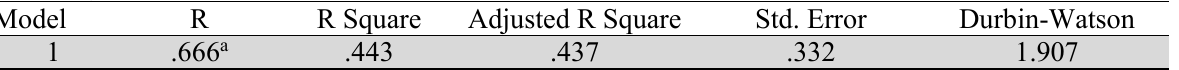
Summary of the models